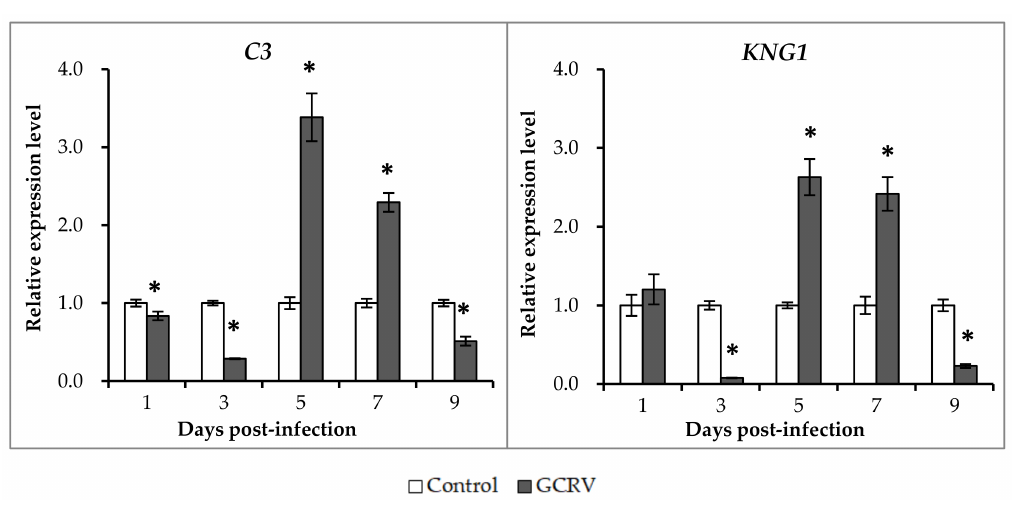
Figure 5. qRT-PCR analysis of the expression levels of C3 and KNG1 after GCRV infection. The relative expression levels of the genes were calculated as the ratio of gene expression level in GCRV infected group relative to that in the control group at the same time-point. All data represent the mean ± standard deviation of three replicates ( n = 5 for each biological duplicate). Significant difference ( p < 0.05) in gene expression level between the two groups are indicated with an asterisk